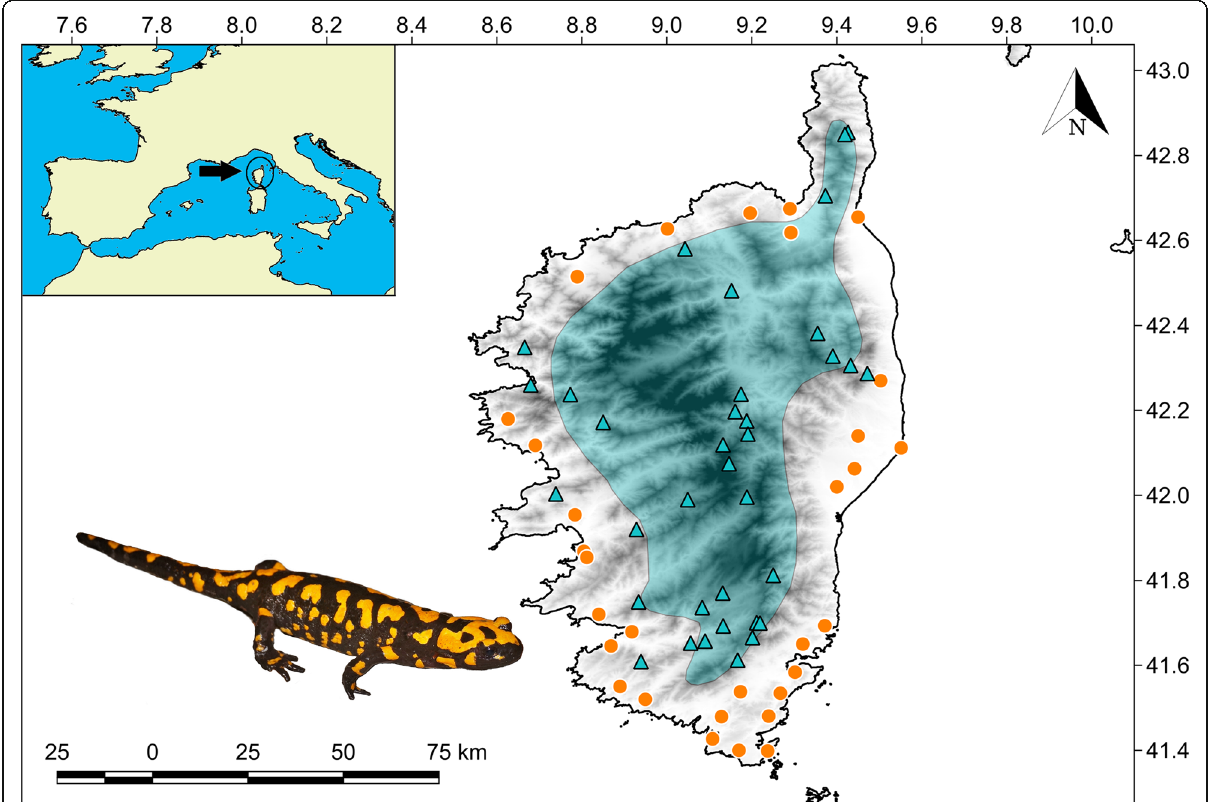
Fig. 1 Map of the study region. The shaded polygon shows the distribution of Salamandra corsica according to the IUCN (International Union for Conservation of Nature and Natural Resources) (2018). Blue triangles, presence sites; orange circles, absence/undetected presence